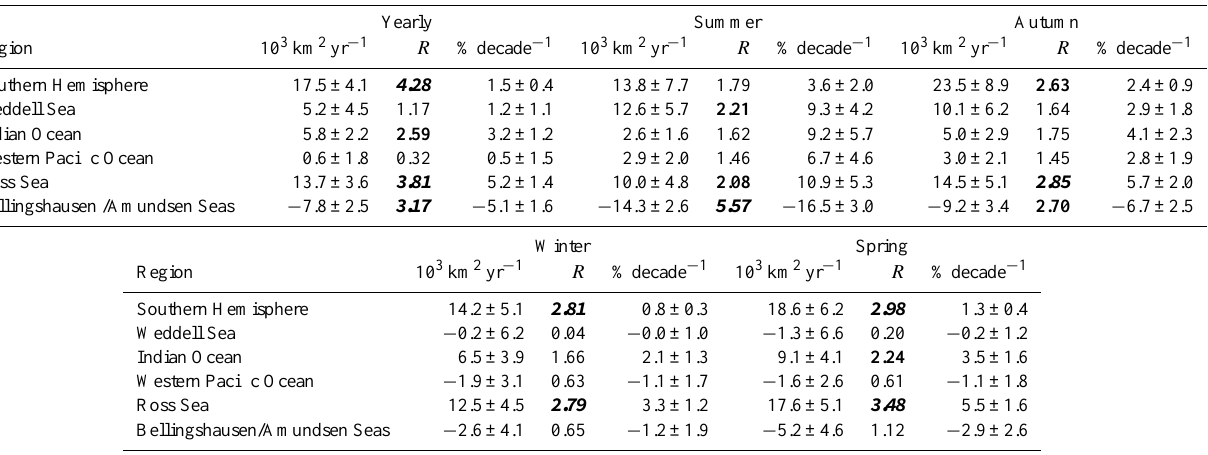
Table 1. Slopes and standard deviations of the lines of least squares fit for the yearly and seasonal sea ice extents in the Southern Hemisphere as a whole and in each of the five regions delineated in Fig. 2, for the period 1979–2010. R is the ratio of the magnitude of the slope to the standard deviation; in the R column, bold indicates statistical significance of 95% and above, and the combination of bold and italics indicates statistical significance of 99% and